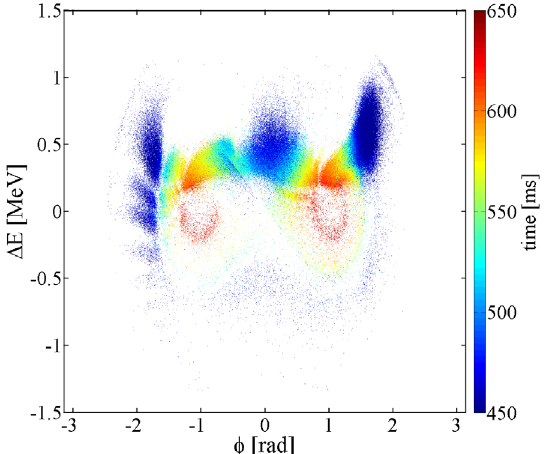
FIG. 11. Simulated position of the lost particles in the longi- tudinal phase space. The color code is the tracking